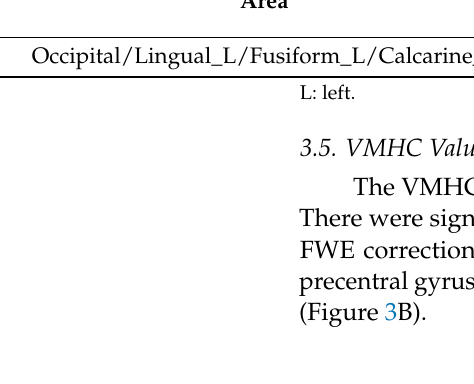
Figure 2. ReHo changes among the three time points: ( A ) Difference of ReHo maps among the three time points; ( B ) extracted clusters of significant ReHo alteration in three time points. *** p < 0.001. Table 4. Regional information of changed ReHo in repeat ANOVA.